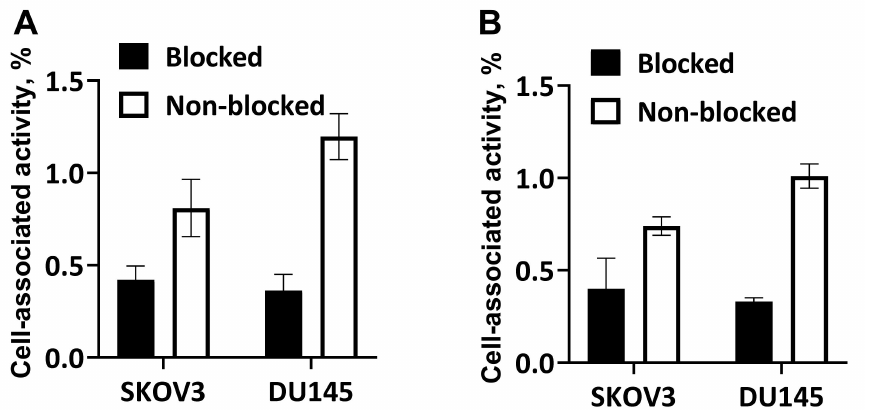
Figure 4. In vitro specificity of [ 68 Ga]Ga-NODAGA-(HE) 3 -Z IGF-1R:4551 ( A ) and [ 111 In]In-NODAGA- (HE) 3 -Z IGF-1R:4551 ( B ) binding to Ì GF-1R-expressing cells in vitro. The data are presented as aver- age ± standard deviation of three samples. The cells were incubated with 1 nM solution of the radiolabeled conjugates. For blocking, receptors were saturated with 1000-fold molar excess of non-labeled conjugate. Binding to blocked cells was significantly ( p < 0.05) lower compared with non-blocked cells.